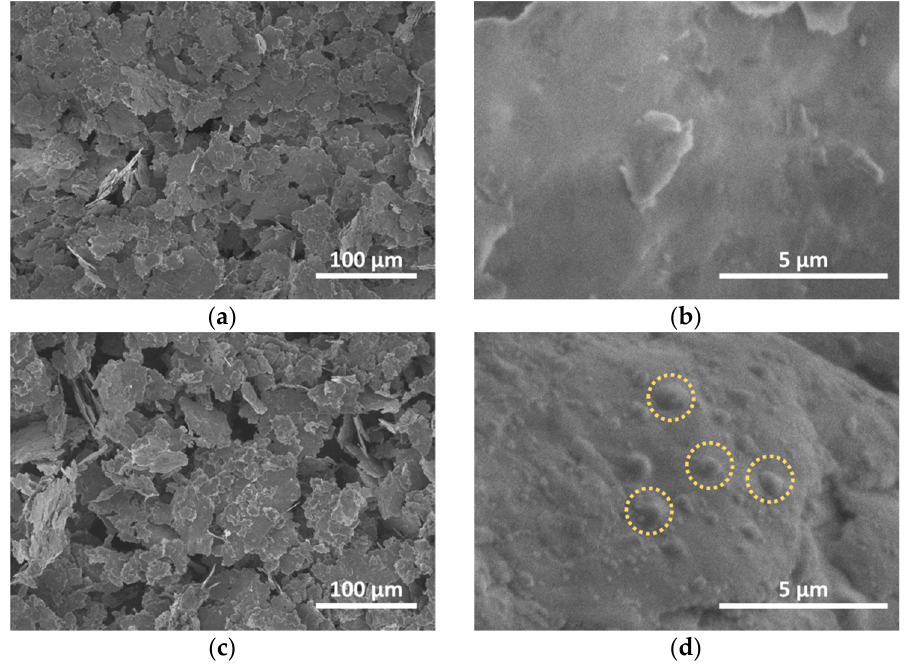
Figure 2. ( a – b ) SEM images of untreated Al powder and ( c – d ) H 2 plasma treated at 250 W for 60